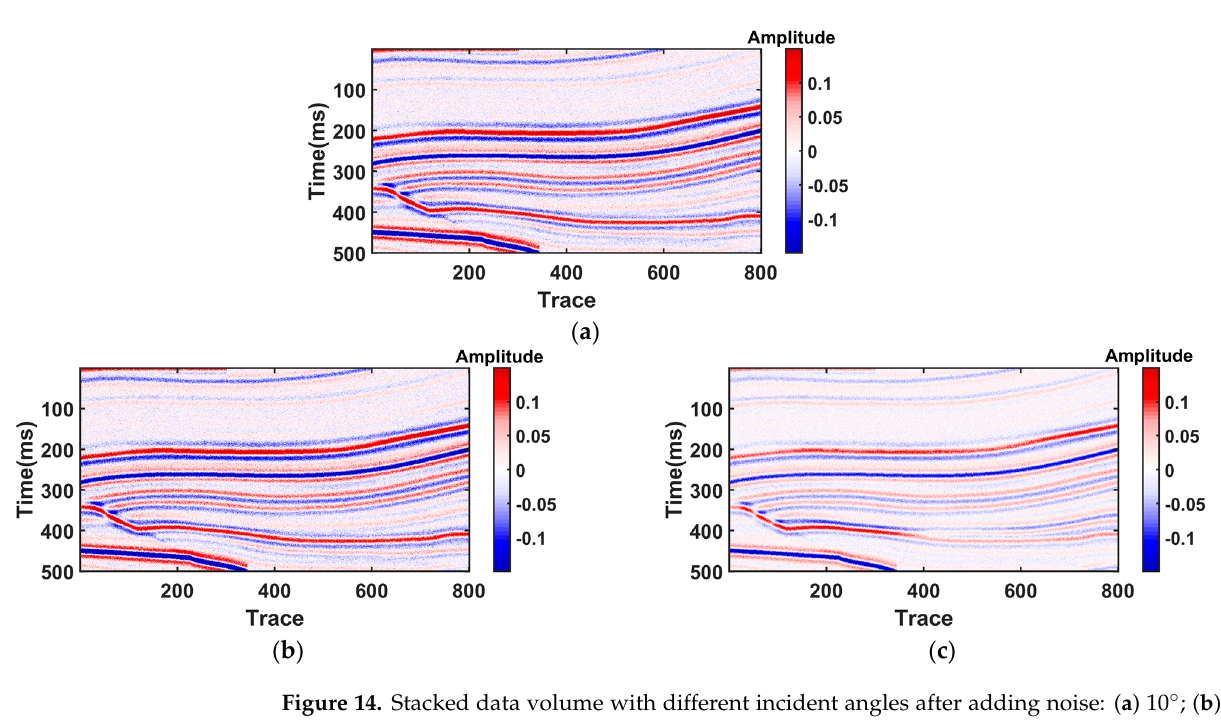
Figure 14. Stacked data volume with different incident angles after adding noise: (a) 10°; (b) 20°; (c) 30°.